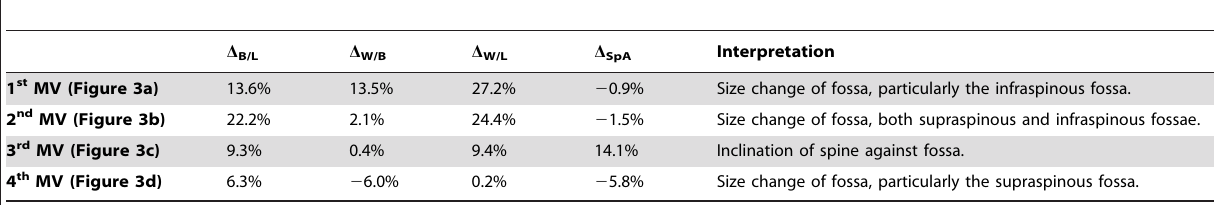
Table 2. Change rates of parameter values for the first four MVs in the ‘without size’ SSM.